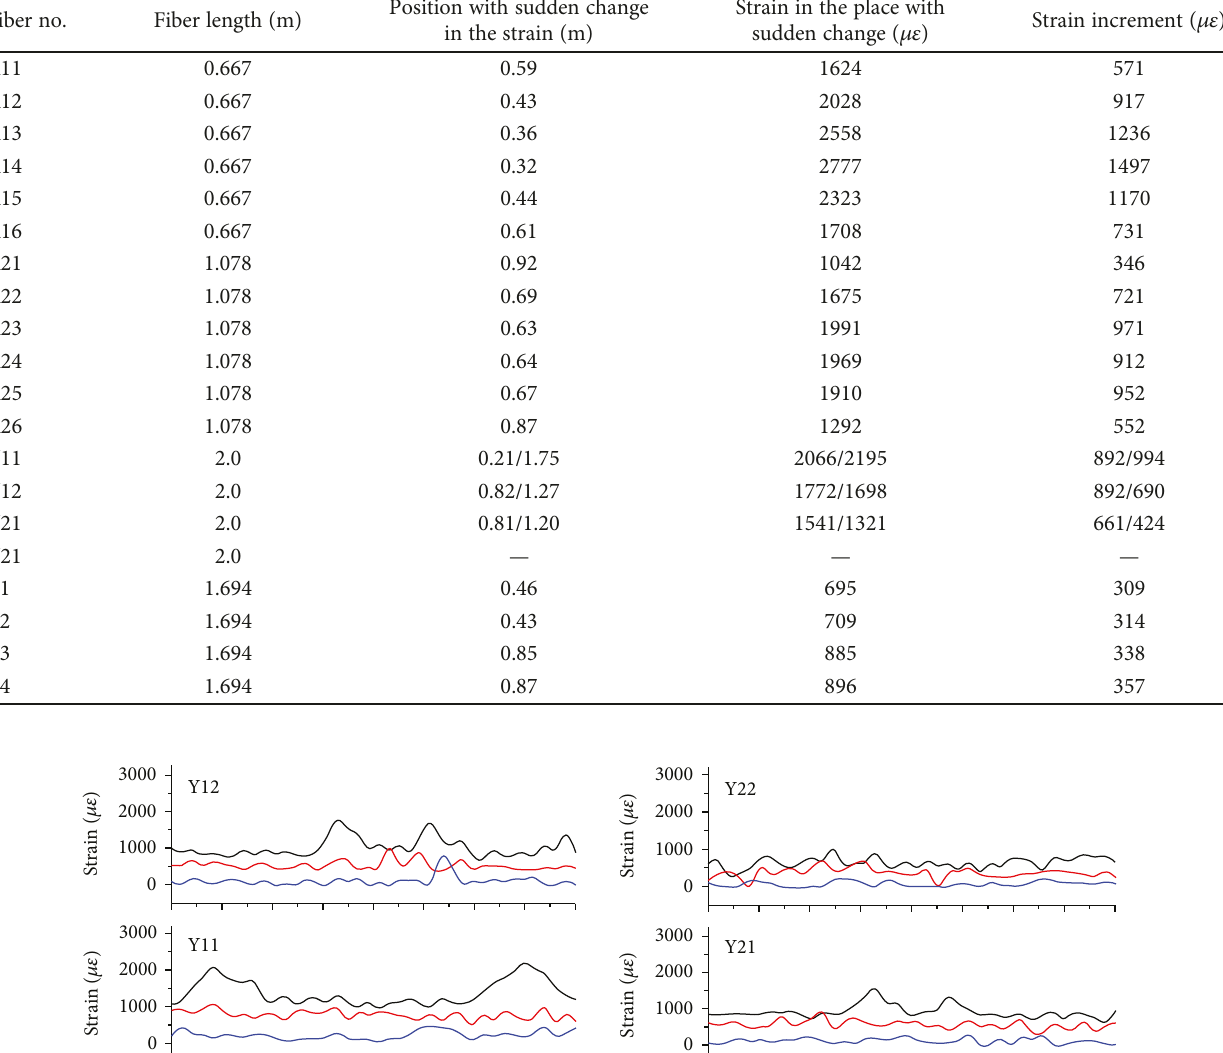
Table 7: Corresponding data of the strain of each optical fi ber.